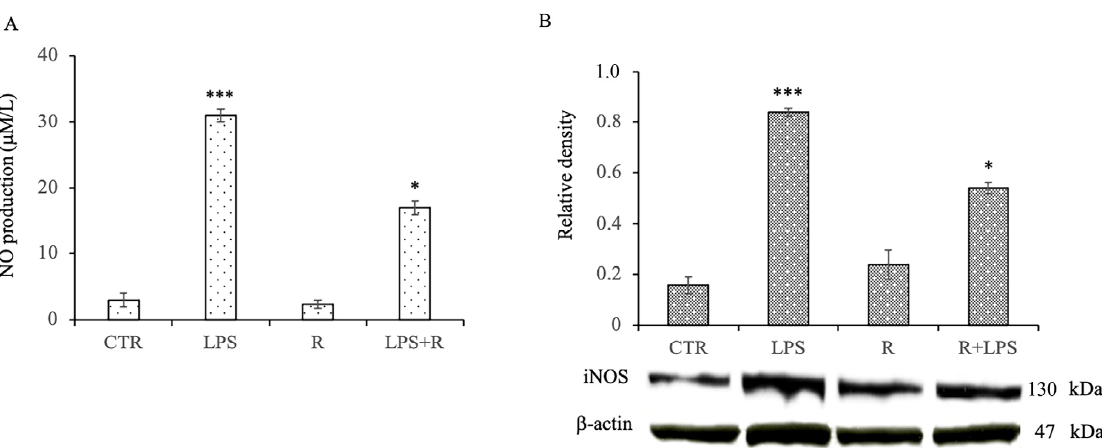
Figure 3. Effects of resveratrol (R) on the cellular oxidative responses in N13 microglial cells stimulated with LPS for 72 h. ( A ) NO release in microglial cells incubated with medium alone (CTR), LPS (100 ng/mL), resveratrol (10 μ M) (R), or resveratrol and LPS (R + LPS). The amount of nitrite in the medium was measured by Griess reaction. ( B ) Immunoblotting detection and densitometric analysis of iNOS in microglial incubated with medium alone (CTR), LPS (100 ng/mL), resveratrol (10 μ M) (R), or resveratrol and LPS (R + LPS). β -actin was used as a loading control. Results are expressed as means ± SD of five independent experiments. *** p < 0.001 LPS vs. CTR.; * p < 0.05 R + LPS vs. LPS.